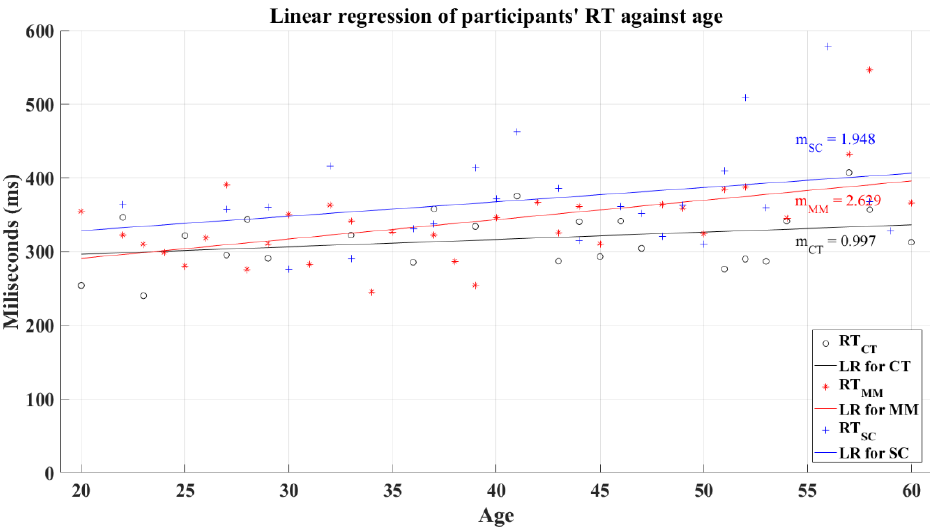
Figure 14. Linear regression for participants’ average reaction time versus age. Black line—linear regression for Control group (LR for CT); red line—linear regression for Mild-Moderate post-COVID group (LR for MM); blue line—linear regression for Severe-Critical post-COVID group (LR for SC); RT CT , Control group’s reaction time; RT MM , Mild-Moderate group’s reaction time; RT SC , Severe-Critical group’s reaction time; m CT , Control group’s slope; m MM , Mild-Moderate group’s slope; m SC , Severe-Critical group’s slope.